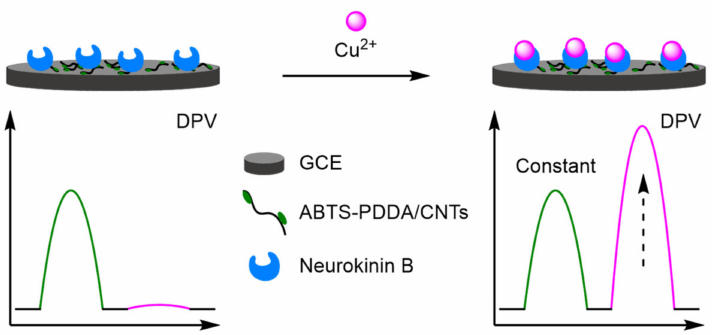
Figure 32. Schematic representation of a carbon nanotube-based modified electrode for the detection of Cu 2+